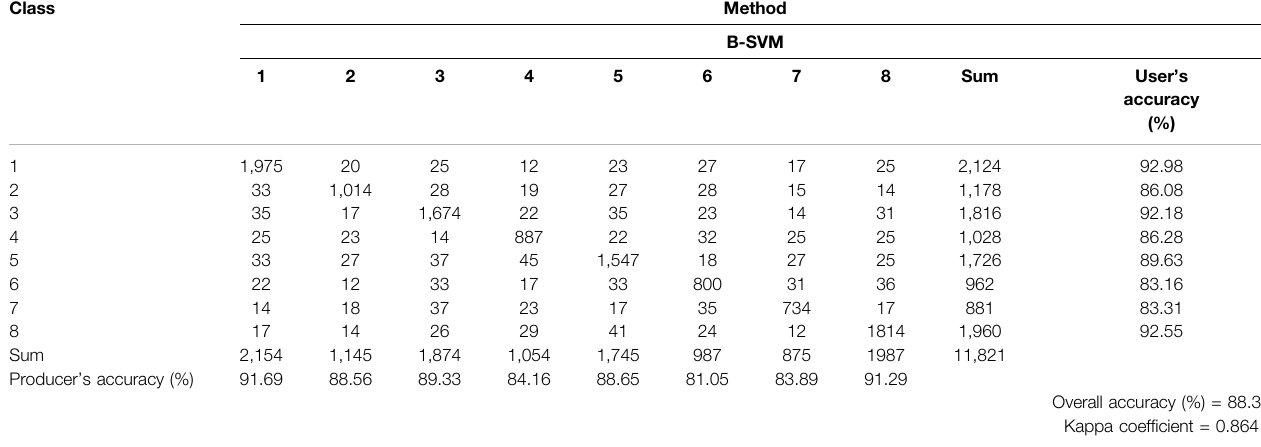
TABLE 3 | Confusion (error) matrix for biased support vector machine (B-SVM) classi fi